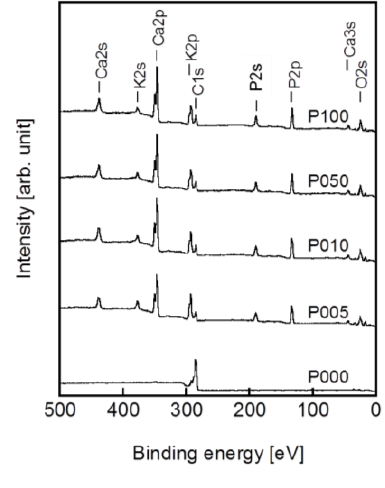
Figure 3. XPS spectra of the surfaces of the plate specimens P000, P005, P010, P050, and